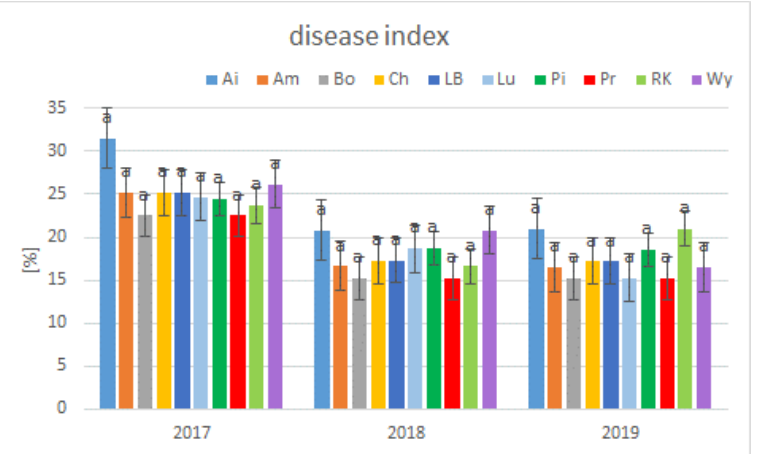
Figure 4. Disease index of canna varieties grow in 2017–2019. Description of cultivars is given in Materials and Methods Section 2.1. The means ± SE is expressed by each value. Values marked with the same letter are not significantly different (α = 0.05).